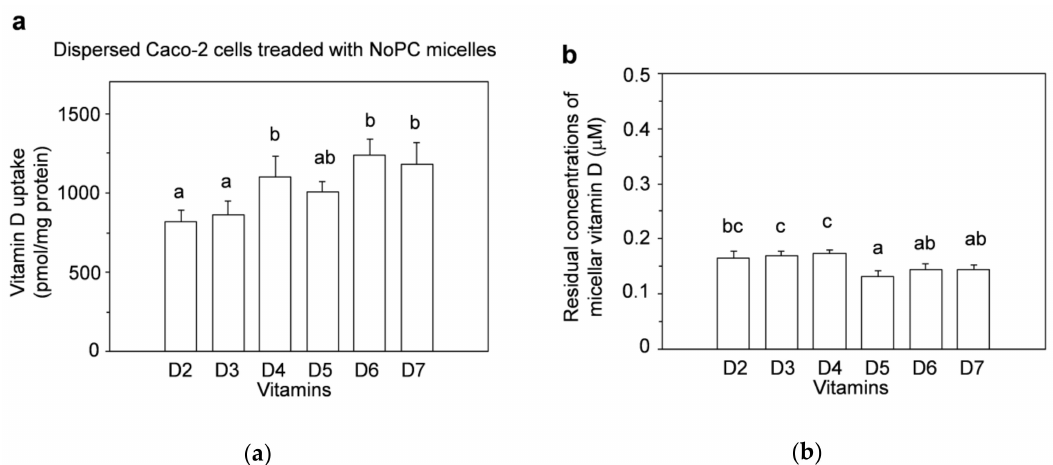
Figure 4. Uptake of vitamin D solubilized in mixed micelles by dispersed Caco-2 cells. Dispersed Caco-2 cells without cell-cell adhesion/cell-matrix adhesion were incubated for 2 h with vitamin D in NoPC mixed micelles. The cells were prepared by dispersing the cells with trypsin. ( a ) Vitamin D uptake by dispersed Caco-2 cells. ( b ) Residual concentrations of the micellar vitamin D after 2-h incubation with the cells. Data are presented as the means ± standard deviation of four wells in a single experiment. Replicate experiments showed a similar trend. Statistical analysis was performed among all six samples in each graph. Values not sharing a common letter were significantly different as determined by Tukey–Kramer test ( p <